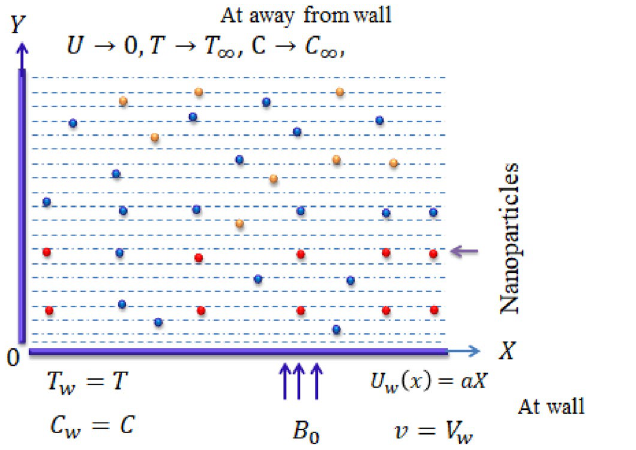
Figure 1. Geometry of current